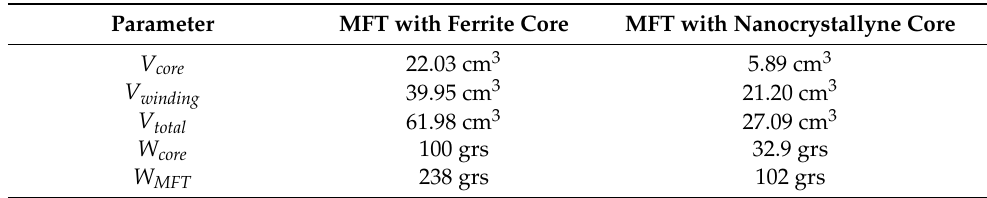
Figure 3. Geometric dimensions of: ( left ): nanocrystalline core, ( right ): ferrite core. Table 3. Volume and weigh of both MFTs.